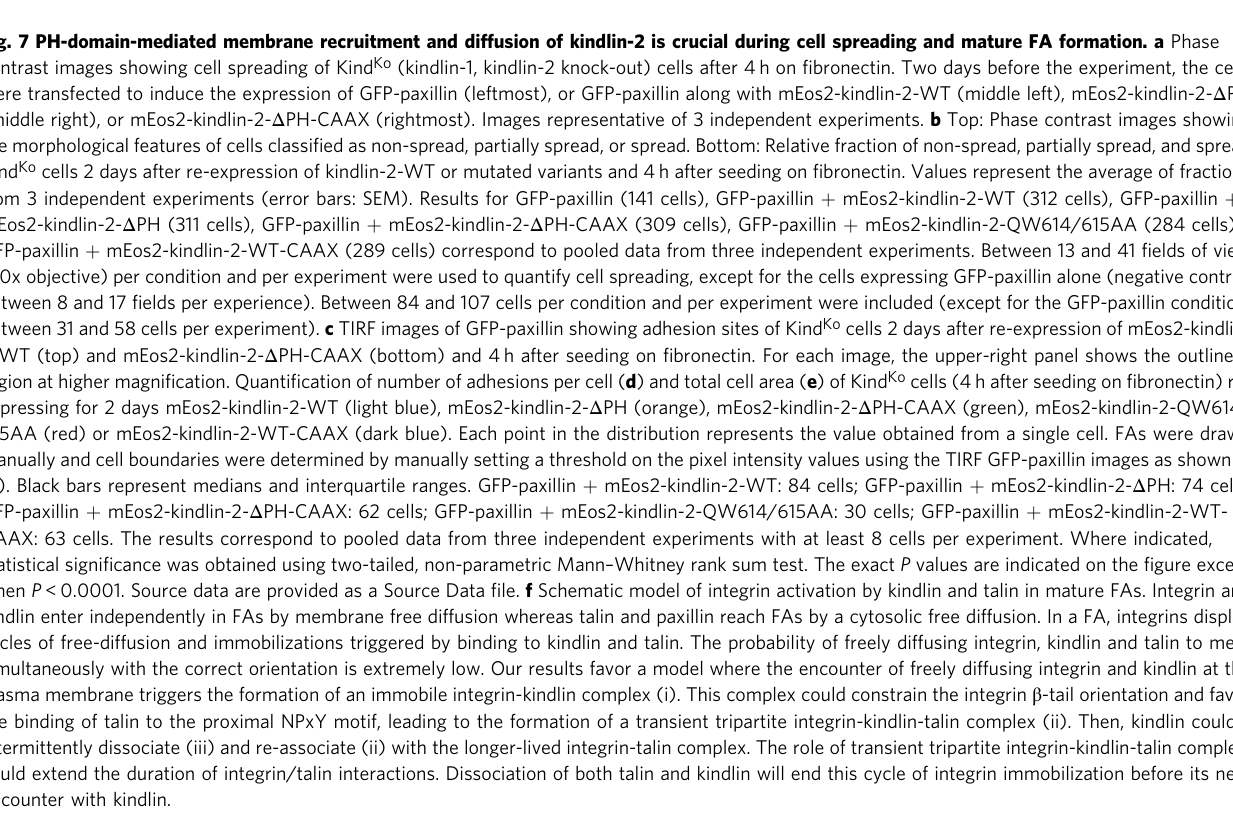
Fig. 7 PH-domain-mediated membrane recruitment and diffusion of kindlin-2 is crucial during cell spreading and mature FA formation. a Phase contrast images showing cell spreading of Kind Ko (kindlin-1, kindlin-2 knock-out) cells after 4 h on fi bronectin. Two days before the experiment, the cells were transfected to induce the expression of GFP-paxillin (leftmost), or GFP-paxillin along with mEos2-kindlin-2-WT (middle left), mEos2-kindlin-2- Δ PH (middle right), or mEos2-kindlin-2- Δ PH-CAAX (rightmost). Images representative of 3 independent experiments. b Top: Phase contrast images